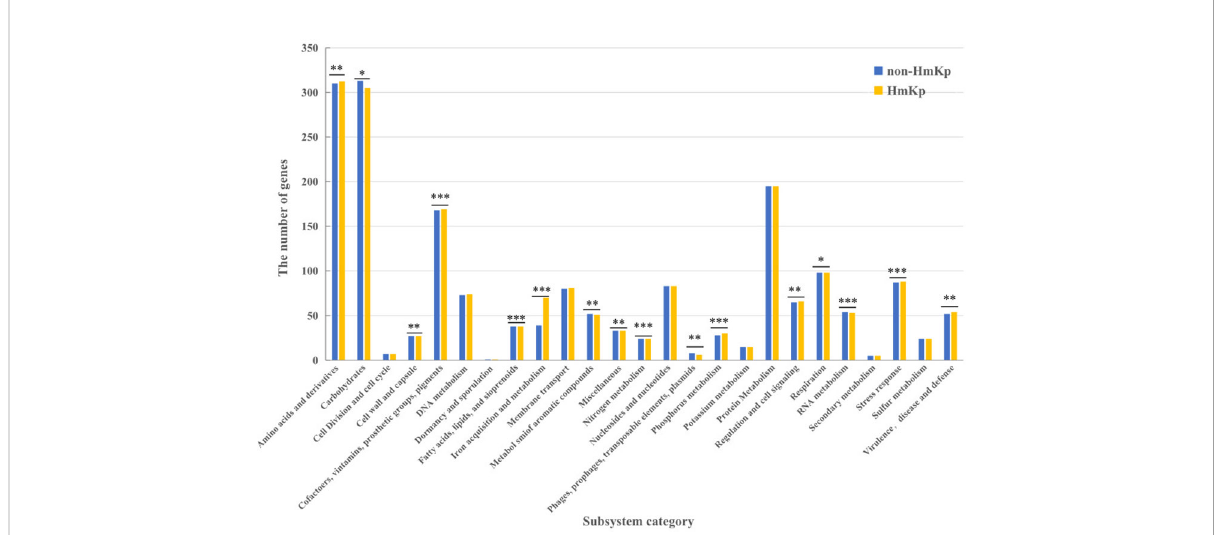
FIGURE 5 Classi fi cations of gene models into functional categories for HmKp and non-HmKp. Gene classi fi cations were performed with RAST functional annotations and the SEED subsystem database .*p < 0.05, **p < 0.01, ***p < 0.001; n.s., not signi fi